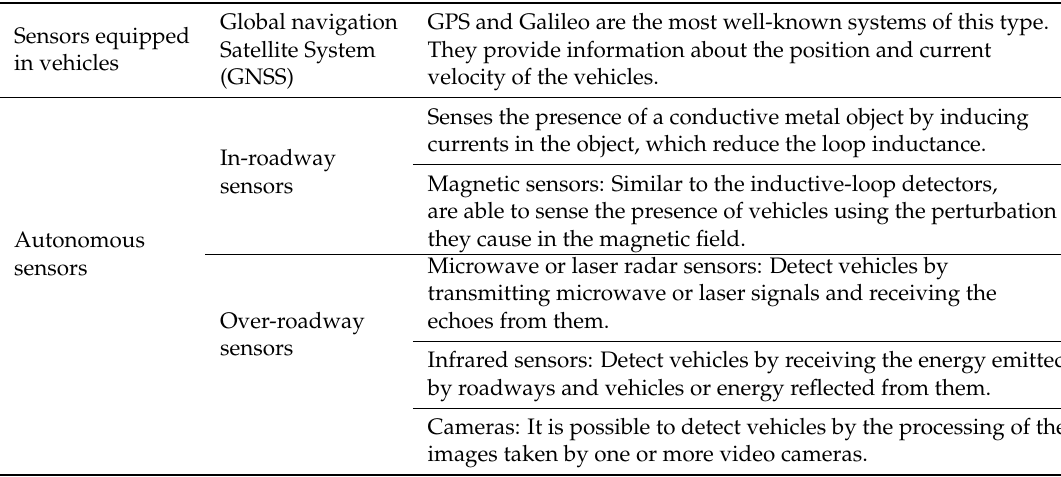
Table 1. Intelligent Transportation Systems’ sensor